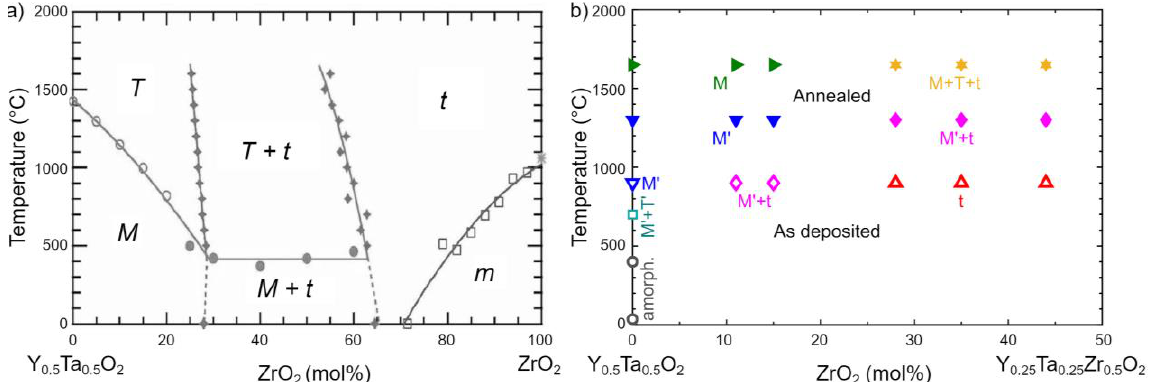
Figure 2. ( a ) Phase diagram along the YTaO 4 –ZrO 2 pseudo binary adapted from Gurak et al. [21]; ( b ) Phases observed in this work for as-deposited samples (open symbols) synthesized at indicated substrate temperatures as well as samples annealed (filled symbols) at 1300 and 1650 °C for various ZrO 2 mol%.